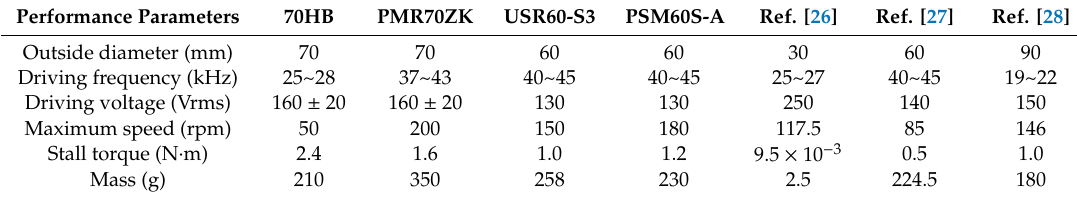
Table 6. Performance comparison between 70HB and other motors.